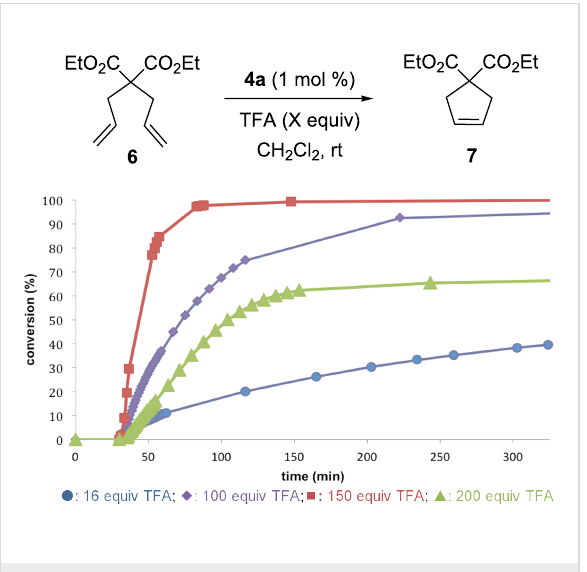
Figure 2: Olefin metathesis profiles in response to TFA equivalents.